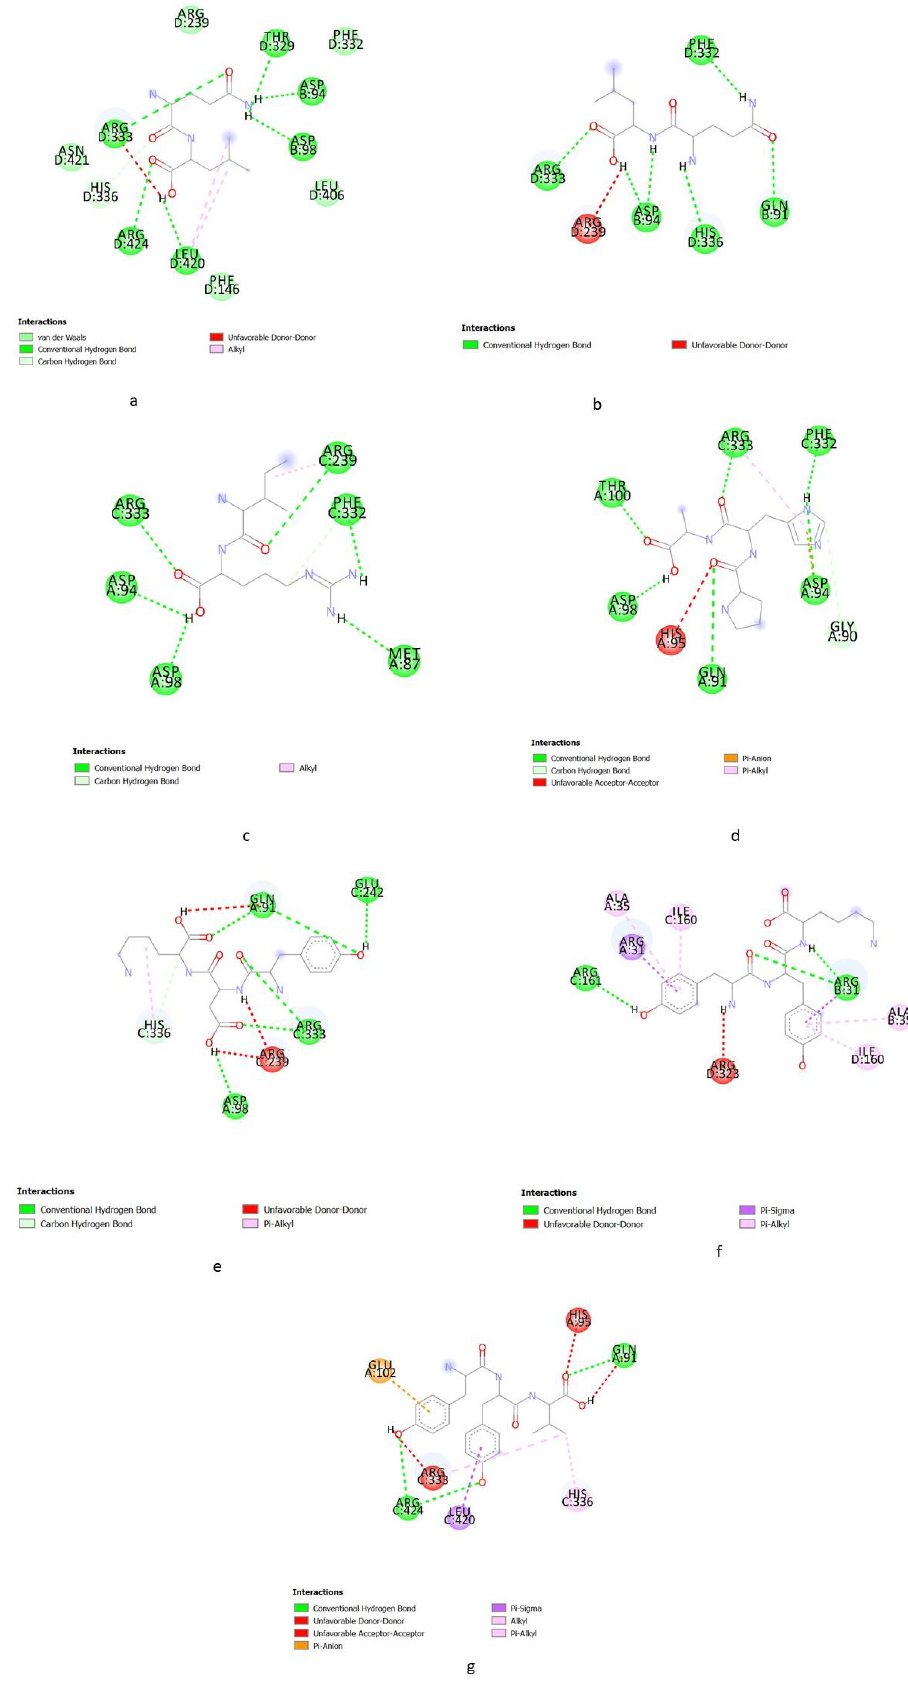
Figure 1. 2D Ligand Protein interaction. ( a ) PHF; ( b )YYL; ( c ) YNL; ( d ) HL; ( e ) IR; ( f ) YYV; ( g ) EL.